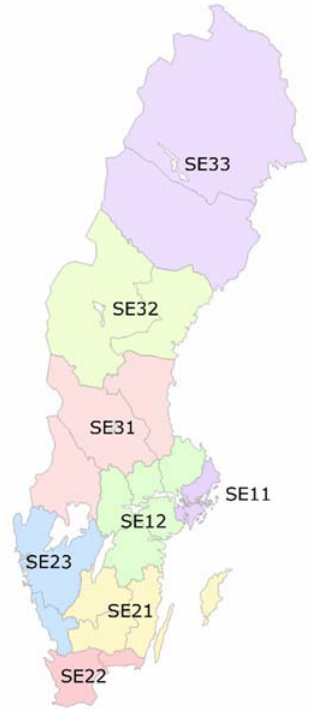
Figure A . National areas of Sweden. Figure A1. National areas of